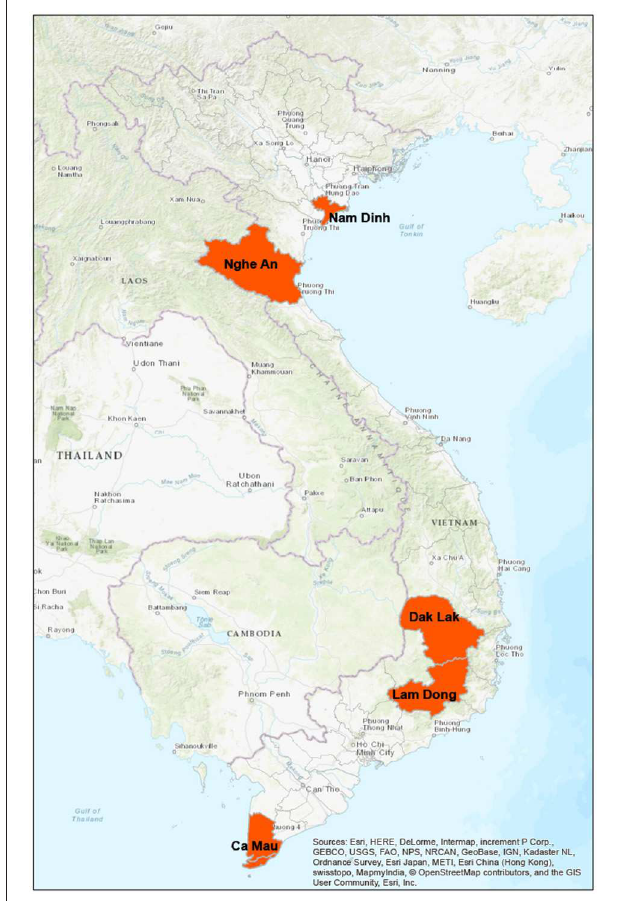
FIGURE 1 | Map of Vietnam with Nam Dinh, Nghe An, Dak Lak, Lam Dong, and Ca Mau indicated with orange